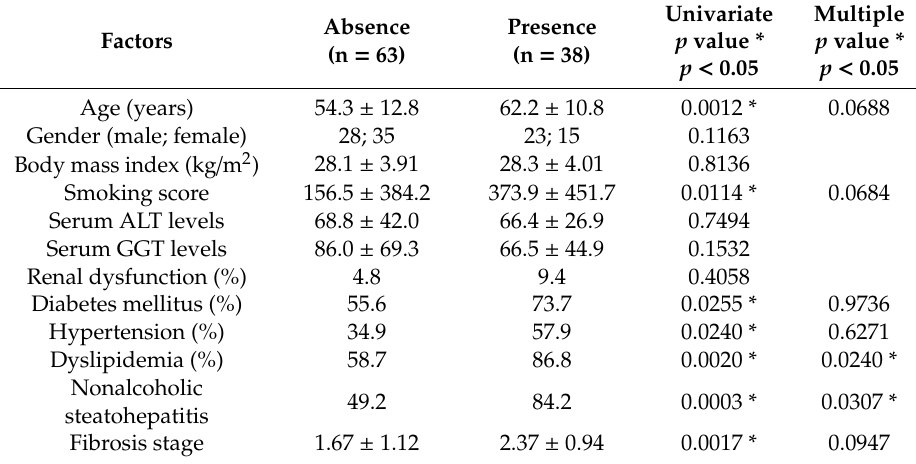
Table 4. Univariate analysis and multiple regression analysis of potential risk factors associated with non-calcified coronary artery plaque in patients with NAFLD. *, statistical significance, p value < 0.05 in Univariate and Multiple regression analysis,